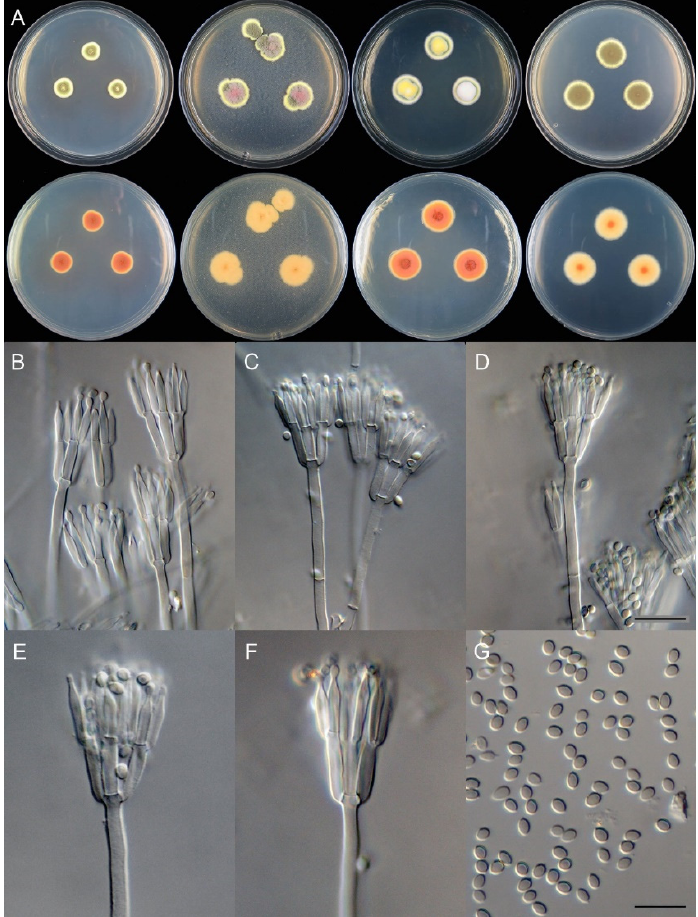
Figure 7. Talaromyces chongqingensis (CS26-67). ( A ) Colonies: top row left to right, obverse CYA, MEA, YES, and PDA; bottom row left to right, reverse CYA, MEA, YES, and PDA; ( B – F )